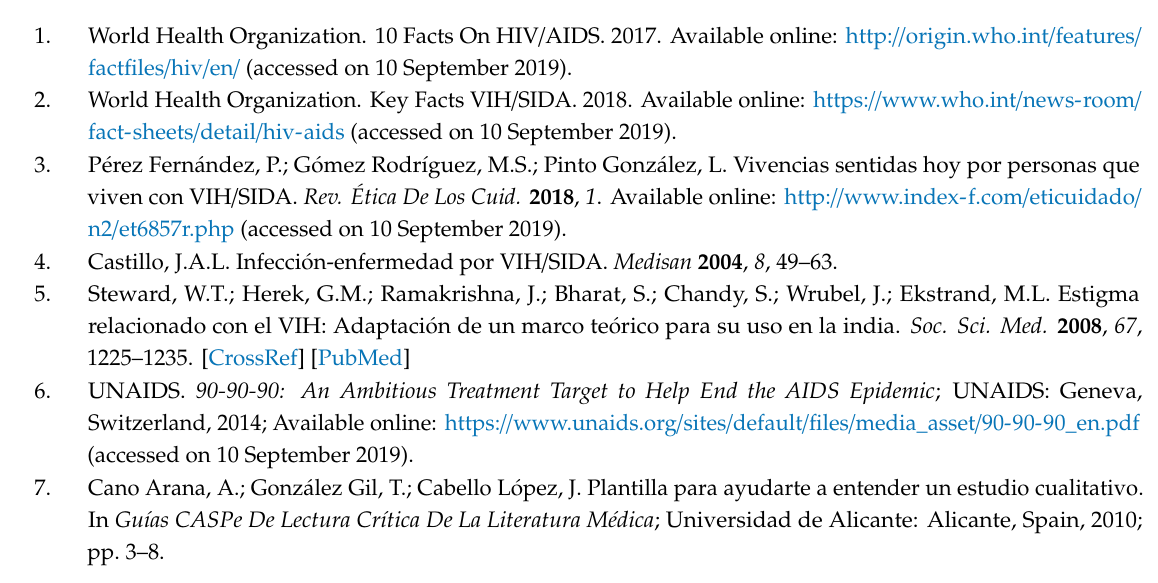
Table S1: Search strategy in the databases; Table S2: Results after the methodological evaluation